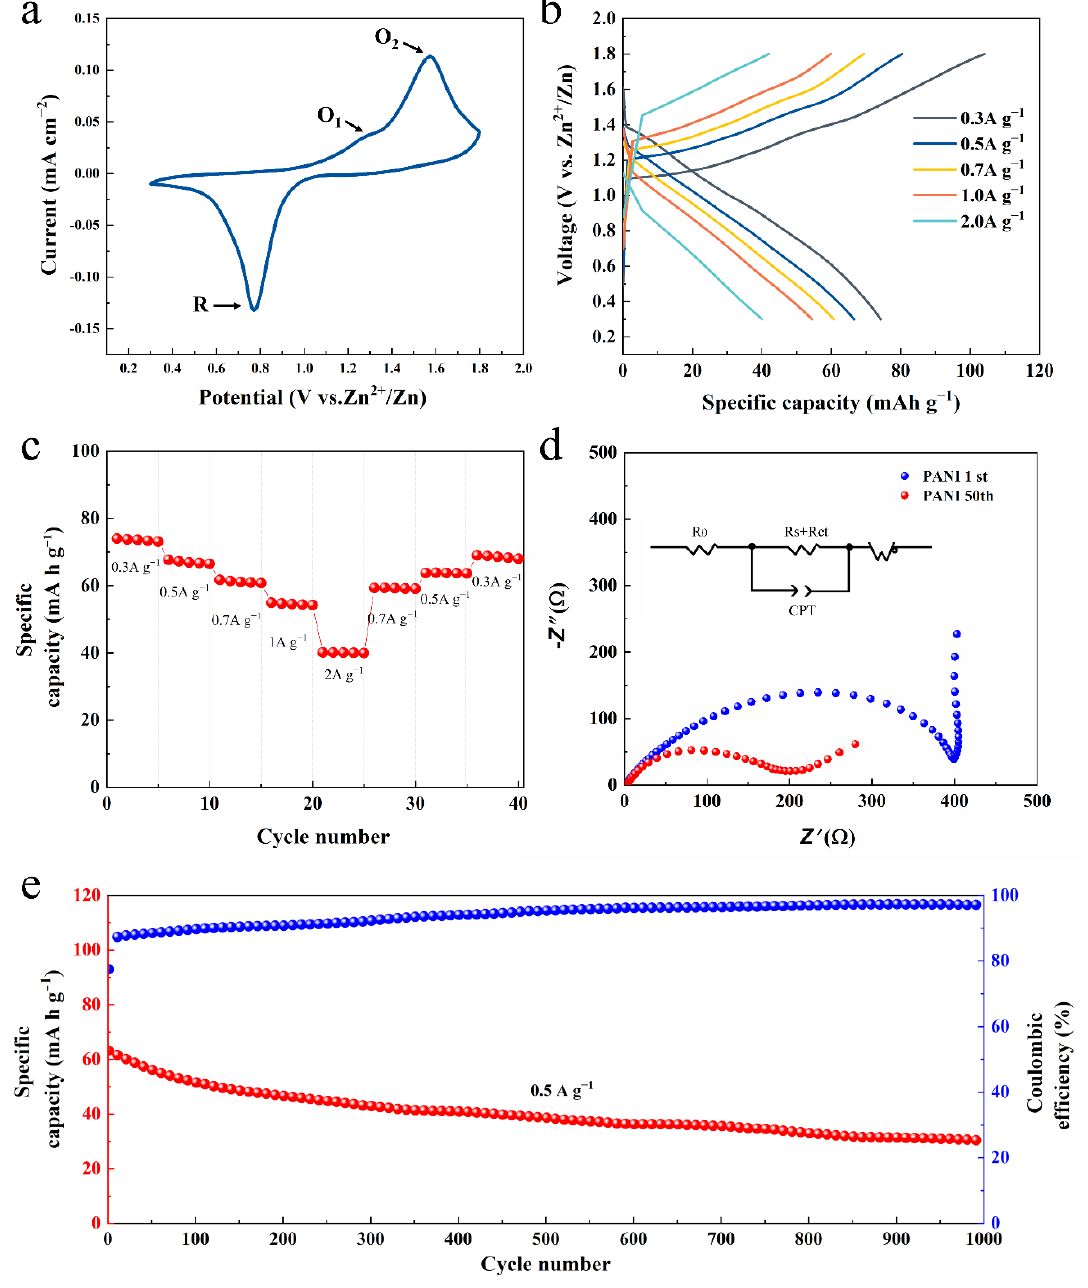
Figure 3. Electrochemical performance of PANI electrode. ( a ) CV curve measured at 0.1 mV s − 1 . ( b ) Typical galvanostatic charge/discharge curves scanned from 0.3 A g − 1 to 2 A g − 1 . ( c ) Rate performance with the charge/discharge current densities varying from 300 to 2000 mA g − 1 . ( d ) EIS Nyquist plots and ( e ) cycling performance of the cell.